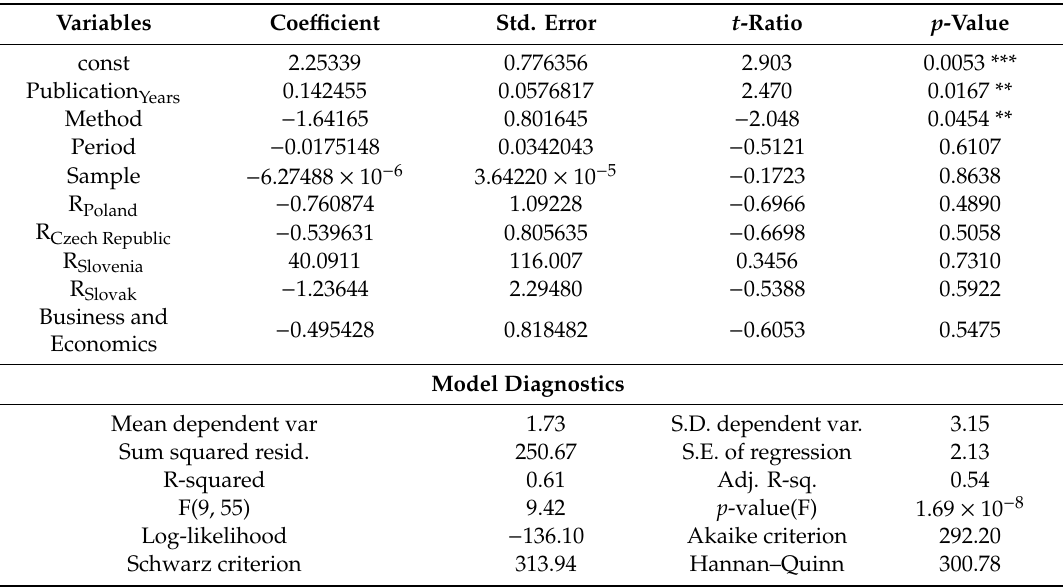
Table 5. The results of the regression